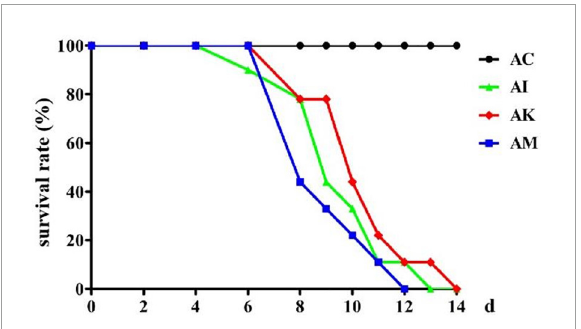
FIGURE1 The survival rate of mice with acute Toxoplasma gondii infection. AC: no T. gondii + PBS; AI: 50 T. gondii cysts + PBS;